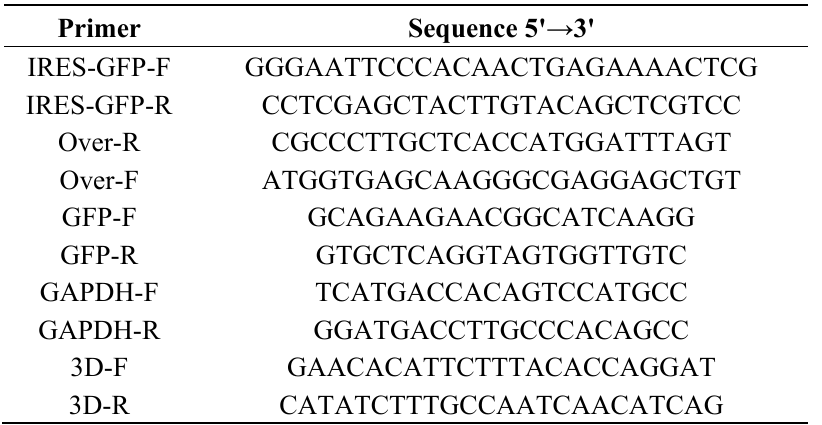
Table 1. Primers used in this